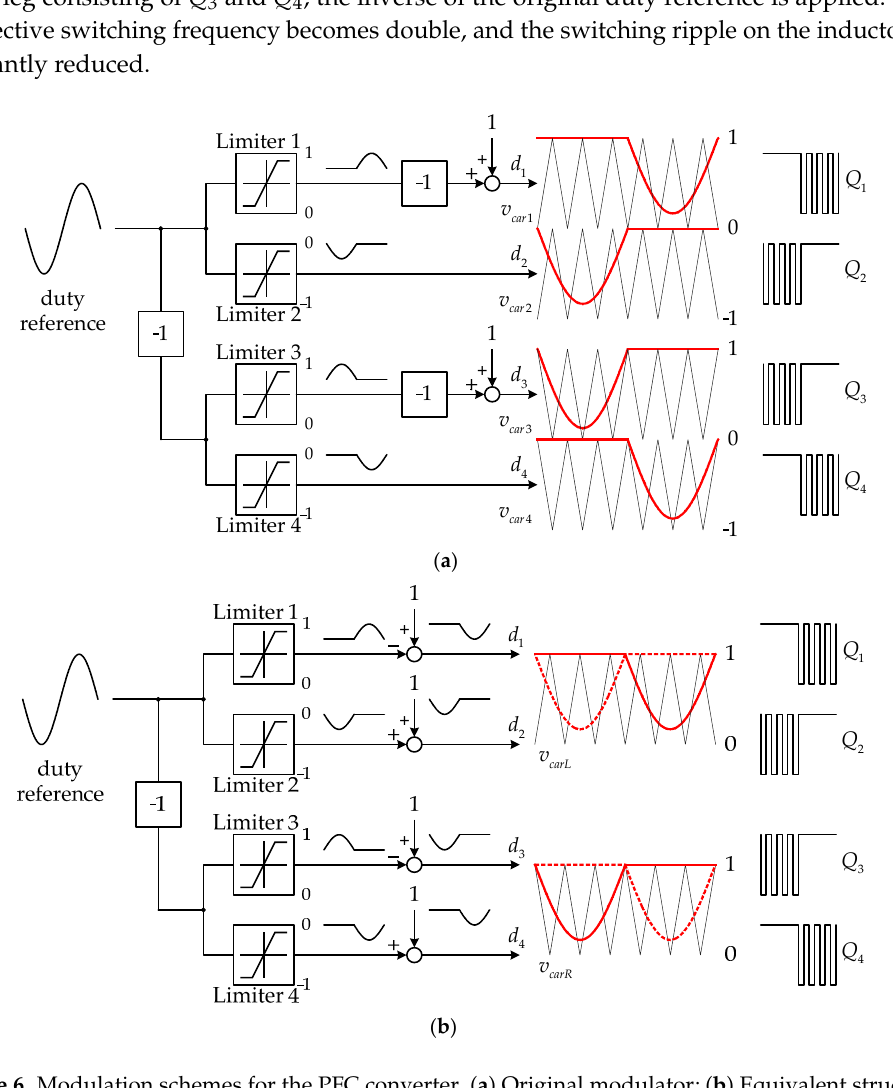
Figure 7. Circuit configuration of the LLC converter.